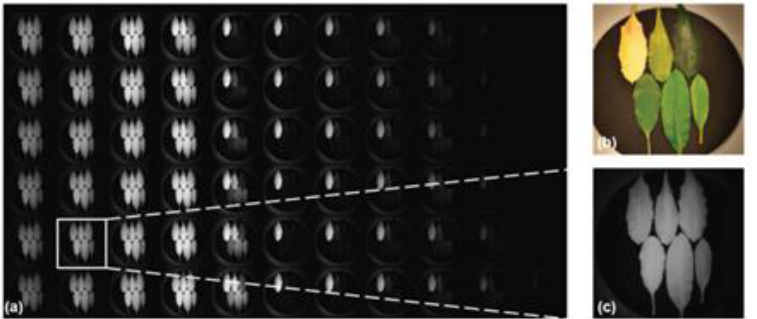
Figure 36. ( a ) Raw image of the multispectral camera with an array of 11 × 6 sub-images. ( b ) RGB image of the object scene using a conventional camera for comparison purposes. ( c ) Magnified image of one separated channel. were used to image green leaves at different stages, and the obtained images were compared to verify that the system had both high spatial and spectral resolutions. the system are shown in Table